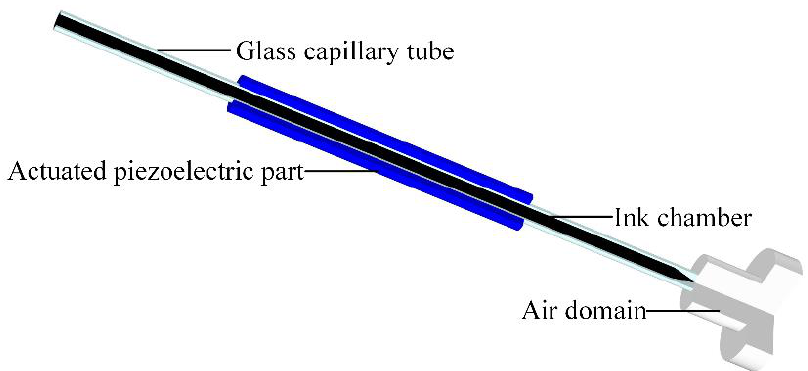
Figure 2. Numerical simulation model built in COMSOL Multiphysics.